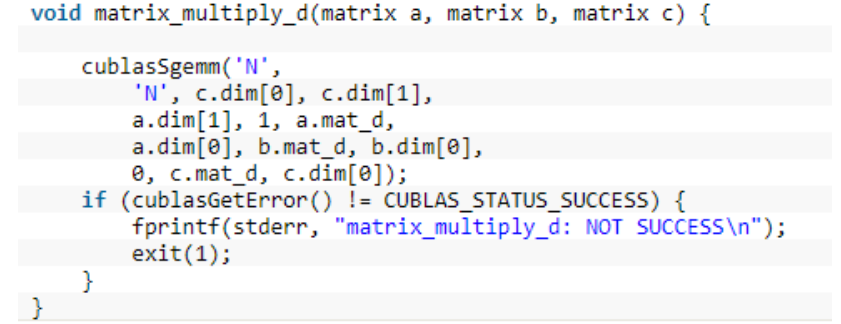
Figure 1. Compute unified device architecture (CUDA) codes for matrix multiplication.